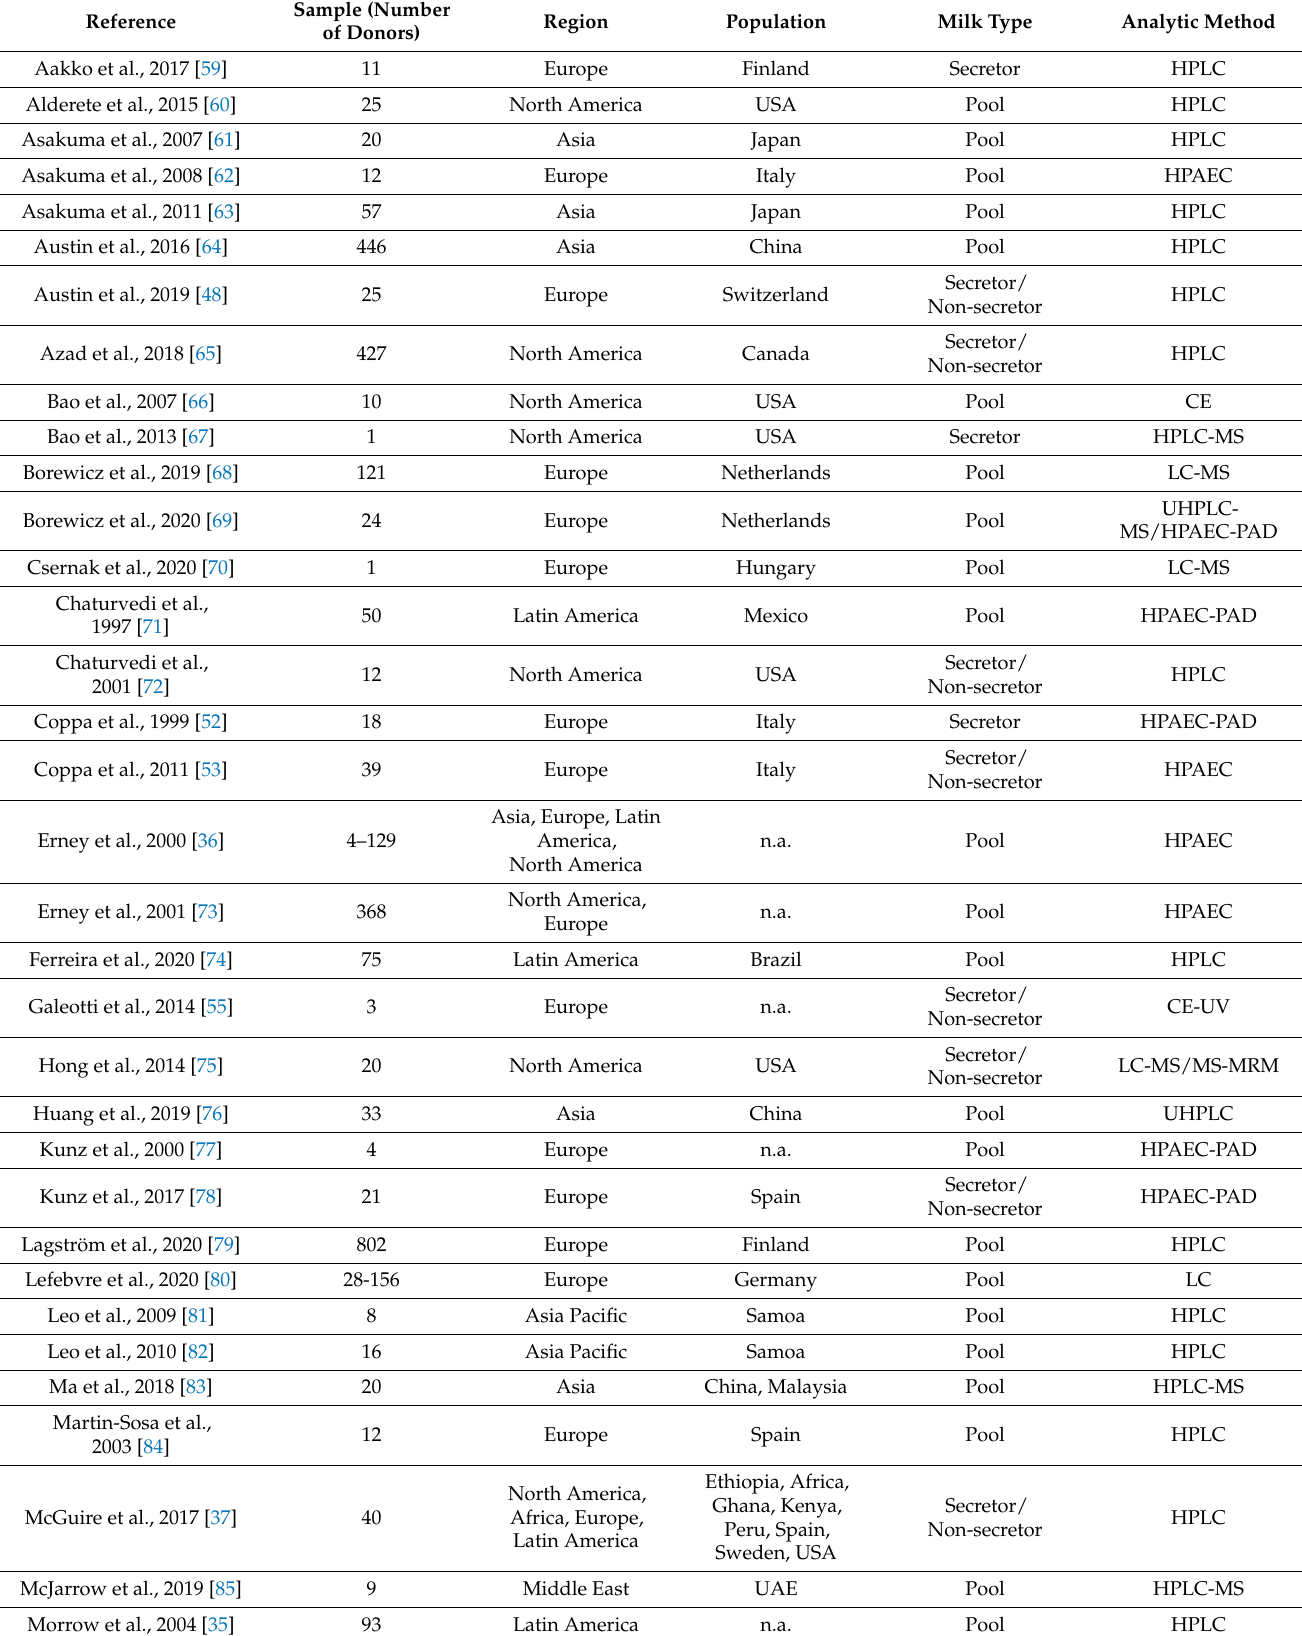
Table 3. Characteristics of the included articles reporting individual HMO concentrations in alphabetical